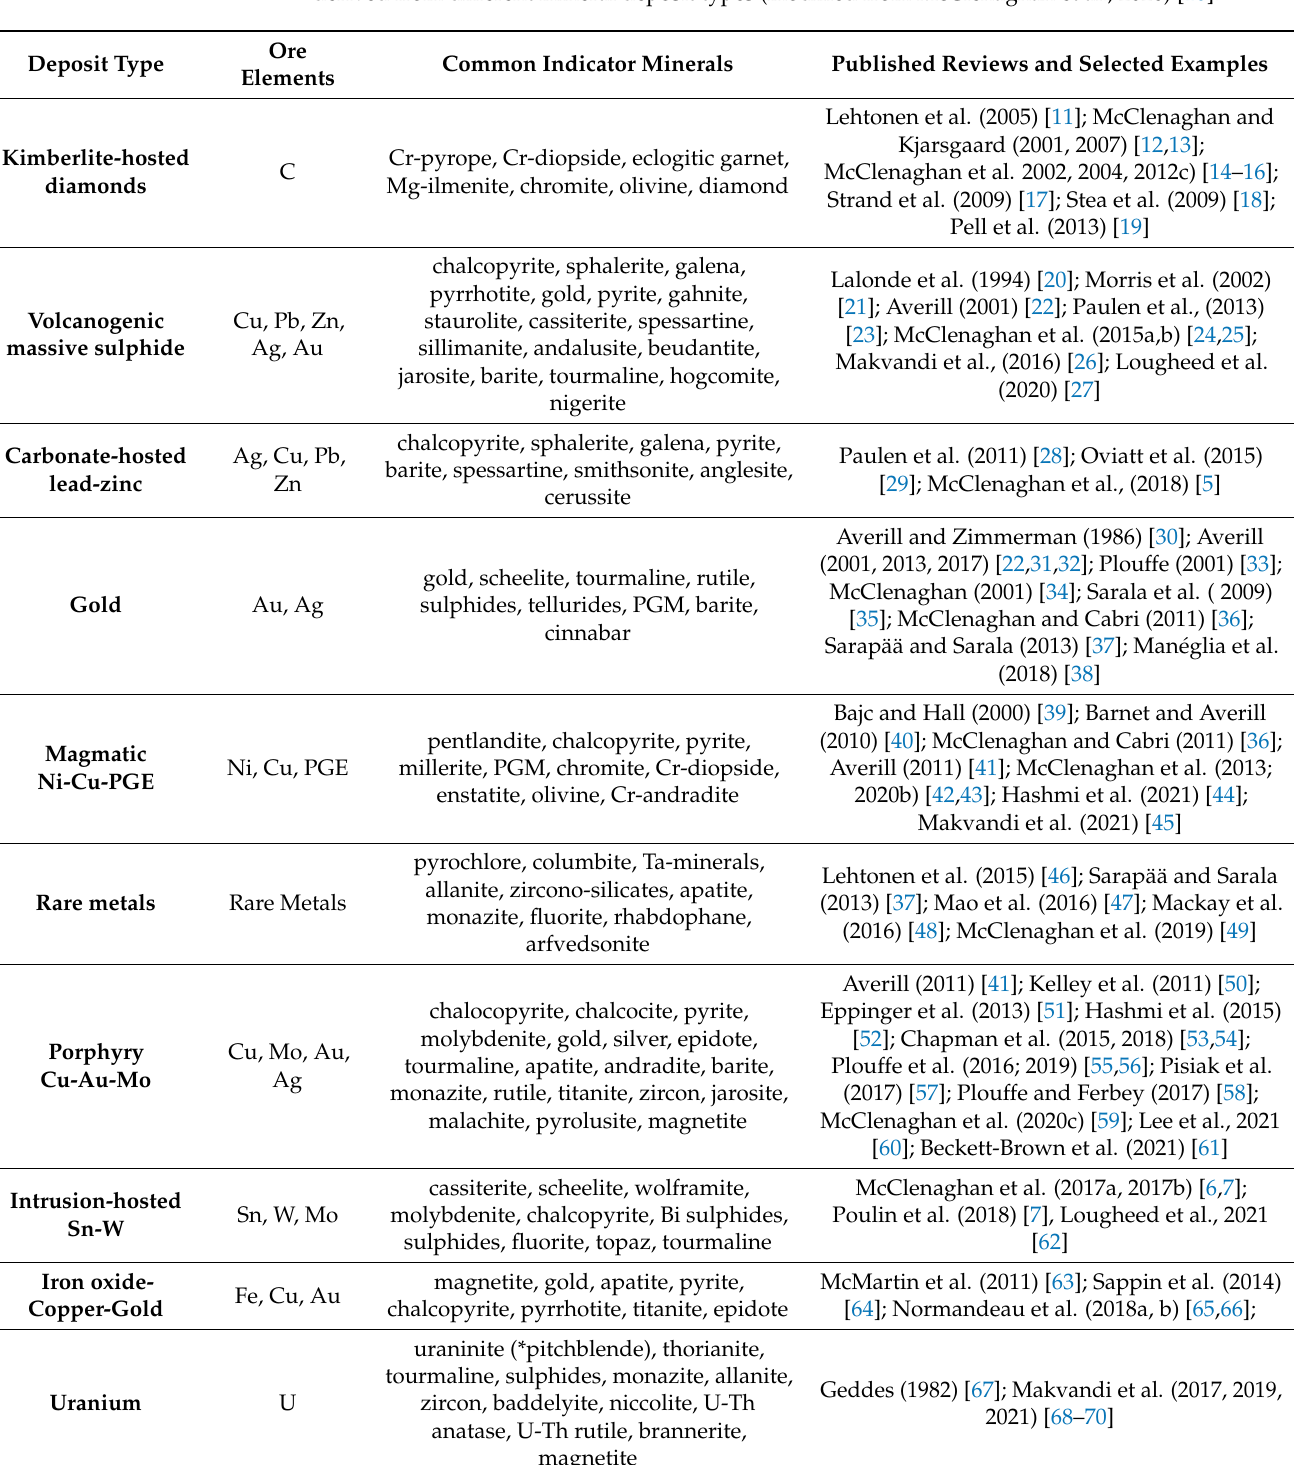
Table 1. Common indicator minerals that can be readily recovered from glacial sediment samples derived from different mineral deposit types (modified from McClenaghan et al., 2020)